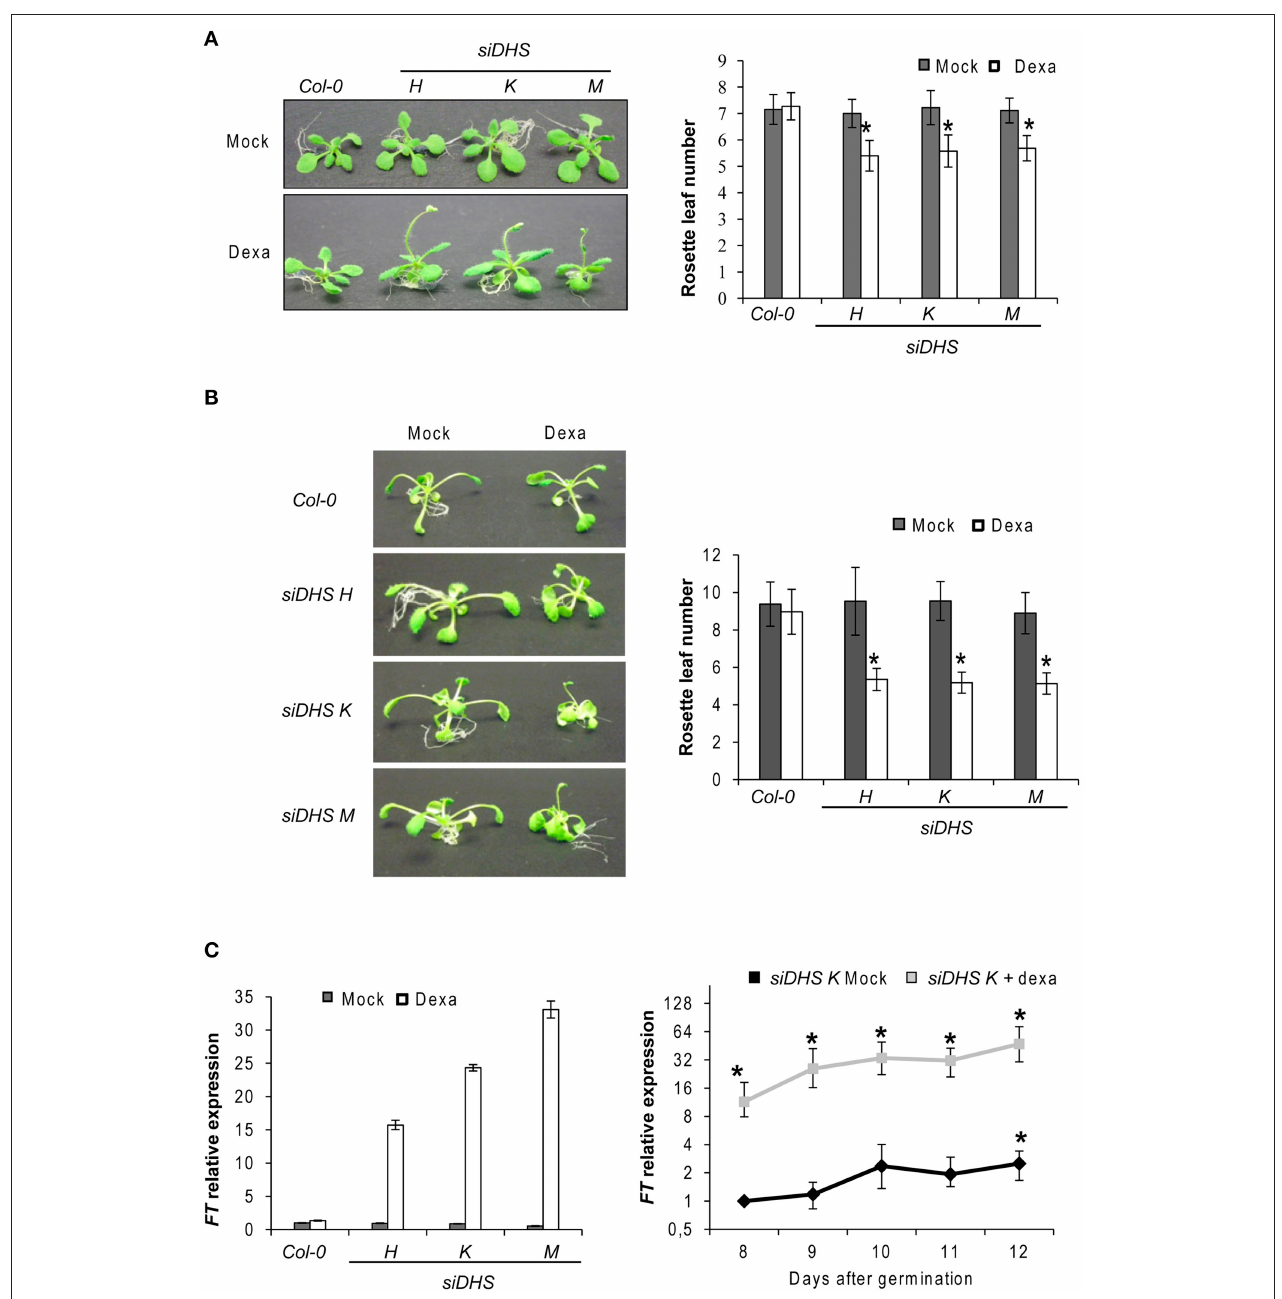
FIGURE 2 | Early flowering phenotype of siDHS dexamethasone-treated plants and FT gene induction. (A) Flowering time phenotypes of representative wild type and siDHS plant seedlings grown in vitro under long-day conditions for 2 weeks with (dexa) or without (mock) dexamethasone are shown in the left side. The flowering time phenotype was quantified by counting the rosette leaf number as shown in the right side. Error bars represent the standard deviation of at least 20 plant seedlings. The data were analyzed by one-way anova test and the asterisks indicate significant differences ( p < 0.05 ) with respect to wild type plants and with respect to the same mock-treated genotype. (B) The flowering phenotype (left) was analyzed for plants grown in vitro under short-day conditions plus 1% sucrose with or without dexamethasone and quantified by counting the rosette leaf number (right). Error bars represent the standard deviation of at least 20 plant seedlings. The data were analyzed by one-way anova test and the asterisks indicate significant differences ( p < 0.05 ) with respect to wild type plants and with respect to the same mock-treated genotype. (C) FT gene expression relative to the mock Col-0 sample was performed by RTqPCR with 9-day-old plant seedlings treated or untreated with dexamethasone (left). Error bars represent standard deviation from three independent technical replicates. The graph on the right shows the time-course of FT gene expression in the transgenic line siDHS-K with or without dexamethasone. Error bars indicate standard deviation from three independent biological replicates and the asterisks indicate significant differences ( p < 0.05 ) with respect to untreated 8-day-old wild type plants.